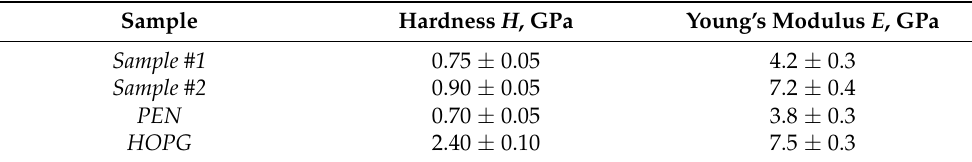
Table 2. Hardness and Young’s modulus measured by AFM nanoindentation on Sample #1 and Sample #2 and compared to PEN and HOPG. Errors are reported as the mean standard deviation from >20 independent